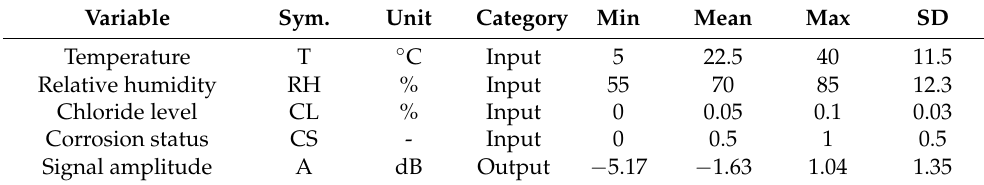
Table 2. Descriptive statistics of the experimental data.